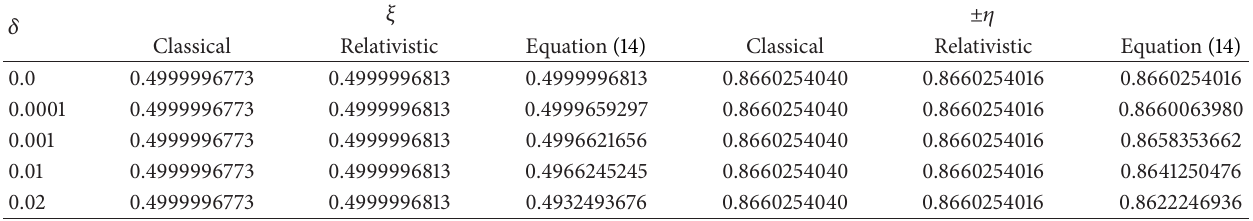
Table 1: Locations of triangular points for the Sun-Mars system: 𝑐 = 12424.24 , 𝜇 = 0.000000322700 , and 𝐴 2 = 0.0000000001 × 10 −8 . 𝜉 ±𝜂 𝛿 Classical Relativistic Equation (14) Classical Relativistic Equation (14)